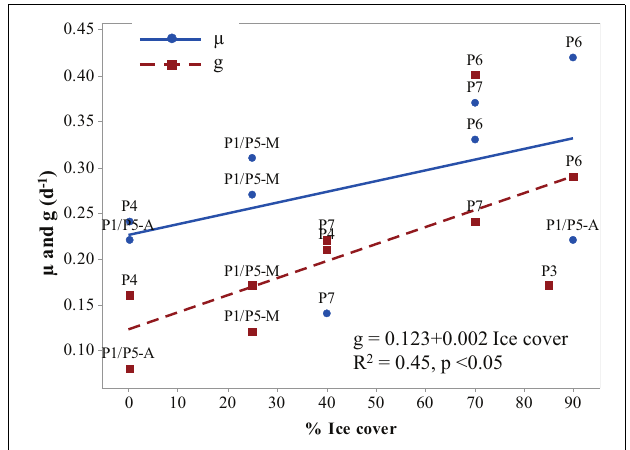
FIGURE 7 | The rates of phytoplankton growth (solid line, circles) and grazing mortality (dashed line, squares) vs. the percentage of sea ice cover at the process stations. P1/P5-M = in May and P1/P5-A = in August.